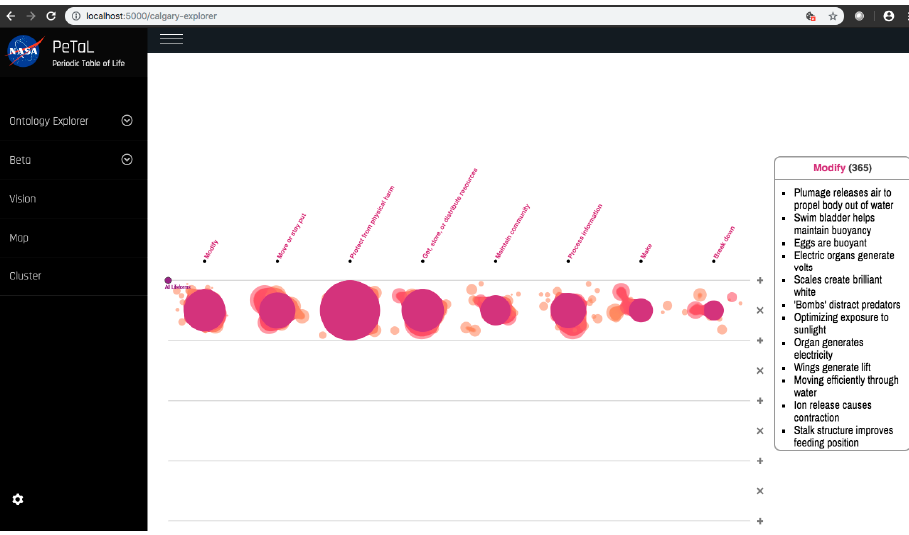
Figure 29. Software architecture of BIRD’s back end. Designs 2019 , 3 , x FOR PEER REVIEW